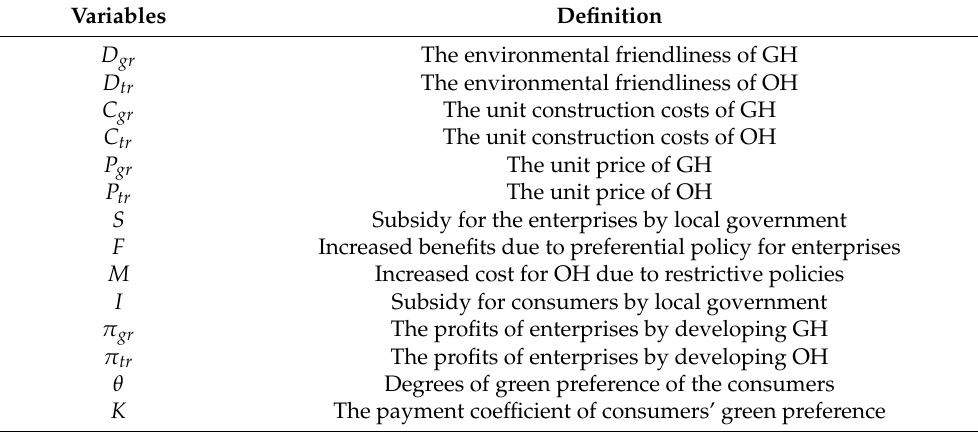
Table 1. Definition of